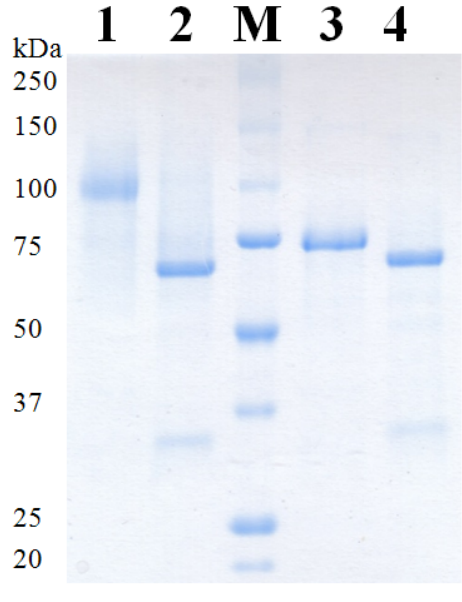
Figure 2. SDS-PAGE of purified PDHs. M, molecular marker; 1, AcPDH; 2, AcPDH deglycosylated; 3, Ax PDH; 4, AxPDH